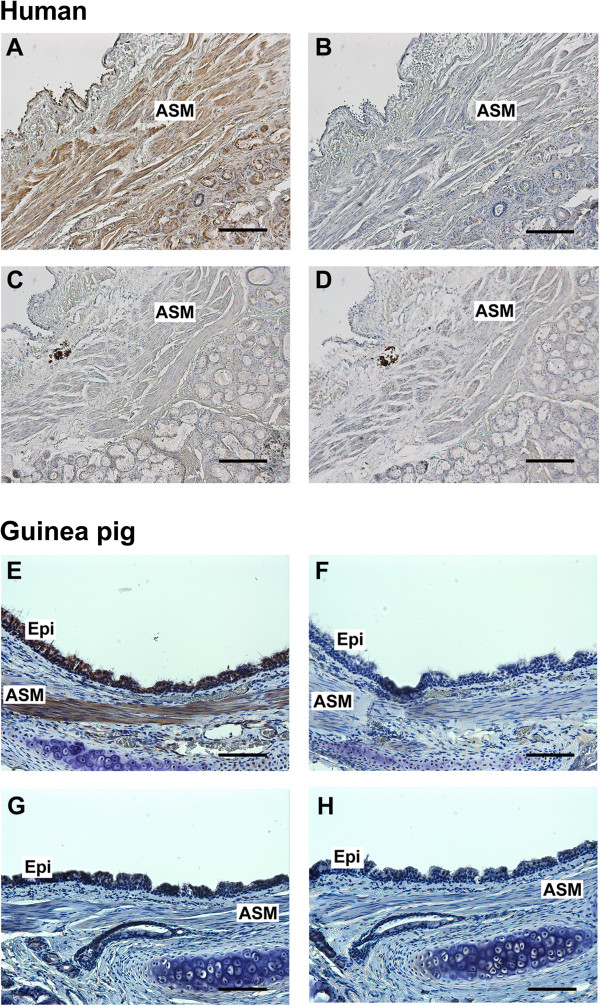
Immunohistochemical detection of dopamine D1 receptor expression in human and guinea pig airway smooth muscle. (A and C) Representative immunohistochemical staining of dopamine D1 receptor (A), and dopamine D5 receptor (C) in paraformaldehyde/glutaraldehyde-fixed human trachea. (B and D) Anti-rabbit IgG isotype negative control in serial section of human tracheal airway smooth muscle. (E and G) Representative immunohistochemical staining of dopamine D1 receptor (E), and dopamine D5 receptor (G) in paraformaldehyde-fixed guinea pig trachea. (F and H) Anti-rabbit IgG isotype negative control in serial section of guinea pig trachea. All sections were counterstained with hematoxylin. Calibration bar: 100 μm. ASM, airway smooth muscle; Epi, airway epithelium. Images are representative of at least 3 independent immunohistochemical analyses from human and guinea pig trachea.